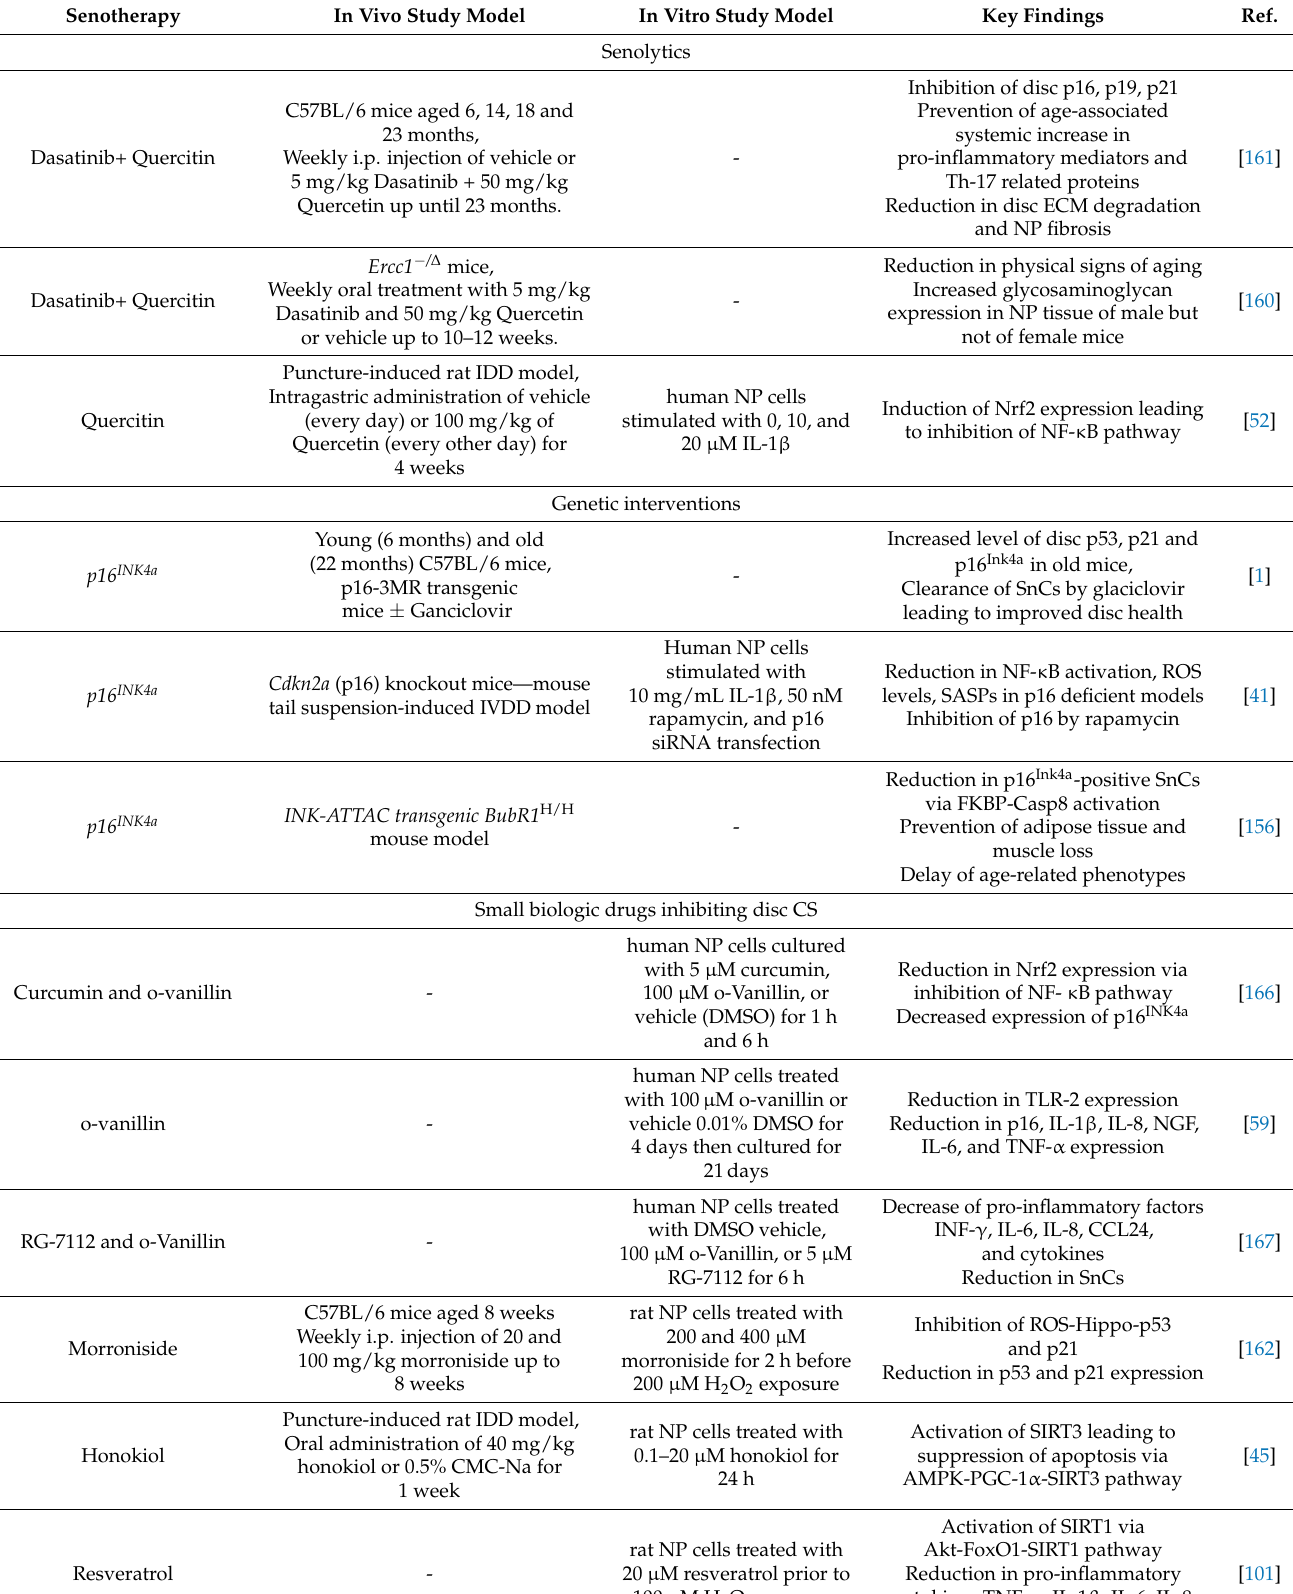
Table 2. Potential therapeutics against cellular senescence in intervertebral